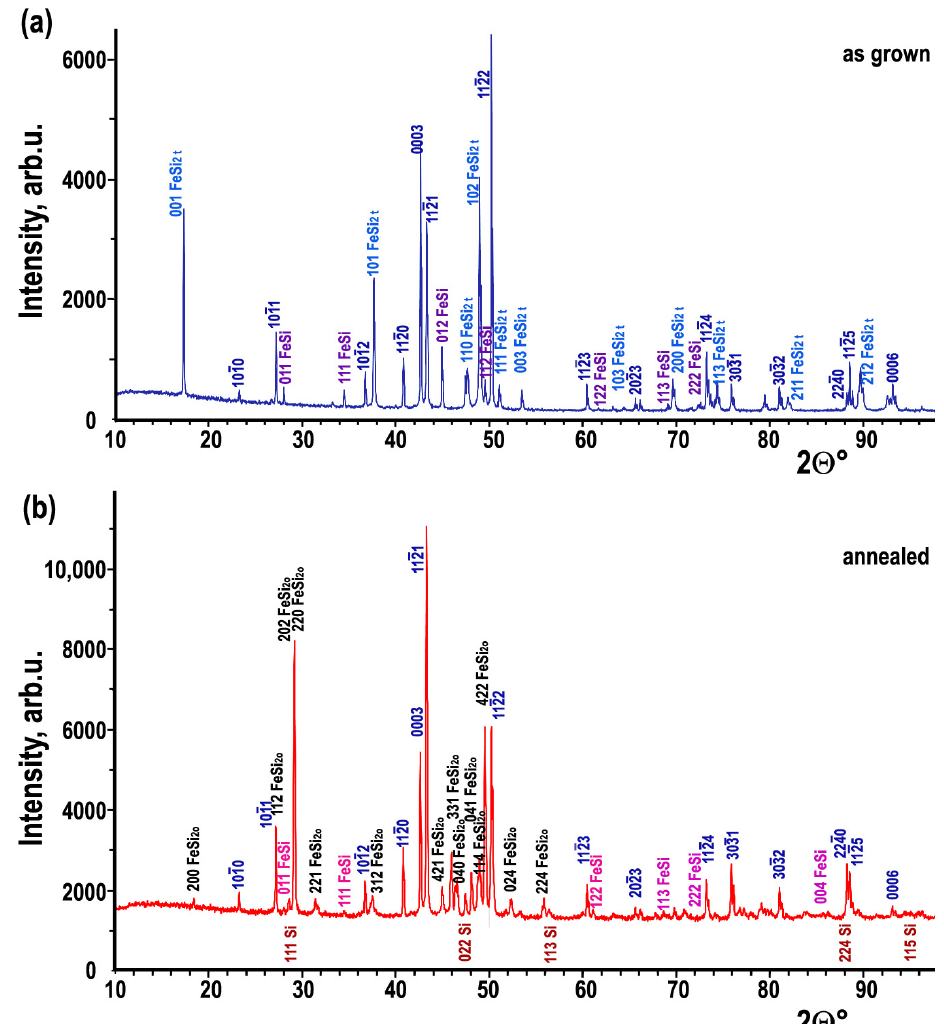
Figure 1. Phase analysis using Rietveld refinement for the Fe − Cr − Si samples before ( a ) and after annealing ( b ). The Bragg peaks of α − FeSi 2 tetr and β − FeSi 2 orth , ε − FeSi and Si cub were labeled with 3 indices, and the planes in hexagonal CrSi 2 are shown with the Miller-Bravais indices ( hkil ), labels of visible Si (111, 022 and 113) peaks are shown under the XRD pattern.